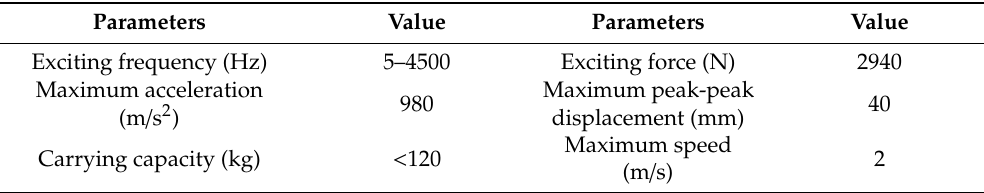
Table 4. Technical parameters of vibration system.